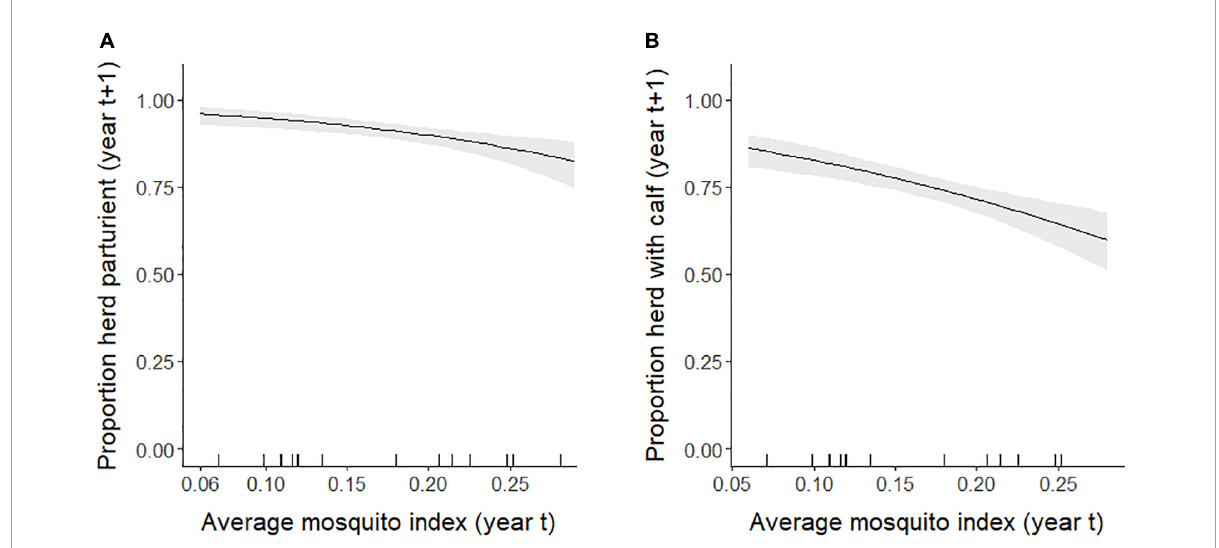
FIGURE7 Annual population-level (A) parturition rates (and 95% confidence intervals) of female caribou modeled as a function of the mosquito index during the previous summer, and (B) late June calving success rates (and 95% confidence intervals) modeled as a function of the mosquito index the previous summer, Central Arctic Herd, Alaska, 2002–2020. The rug plot along the bottom of the figure depicts the distribution of data.